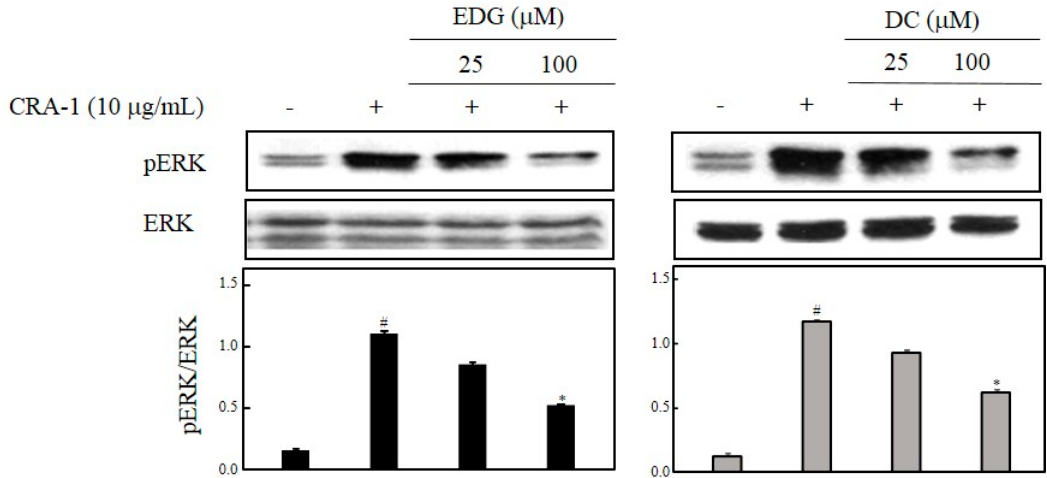
Figure 5. EDG and DC effects on Fc ε RI-mediated extracellular-regulated kinase (ERK) 1/2 activation. Cells treated with EDG and DC under serumfree conditions, and stimulated with CRA-1. Cellular lysate was obtained, and protein expression assessed via Western blot analysis using antiphospho ERK 1/2 and ERK 1/2 antibodies. Results presented as mean ± SD of three independent experiments. Relative density calculated as ratio of each protein expression to ERK. # p < 0.05 vs. non-treated group; * p < 0.05 vs. CRA-1-treated group.